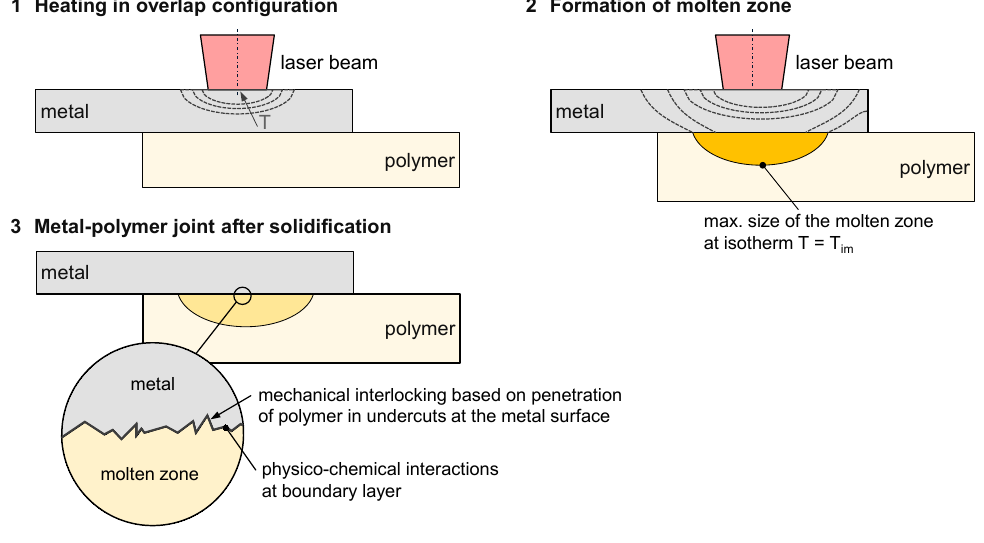
Figure 1. Process steps of laser-based metal–polymer joining.